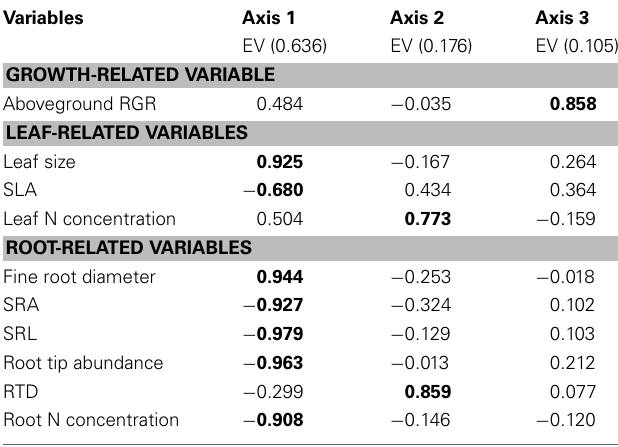
Table 7 | Principal Components Analysis of the eight poplar demes with respect to relative growth rate and leaf and root morphological